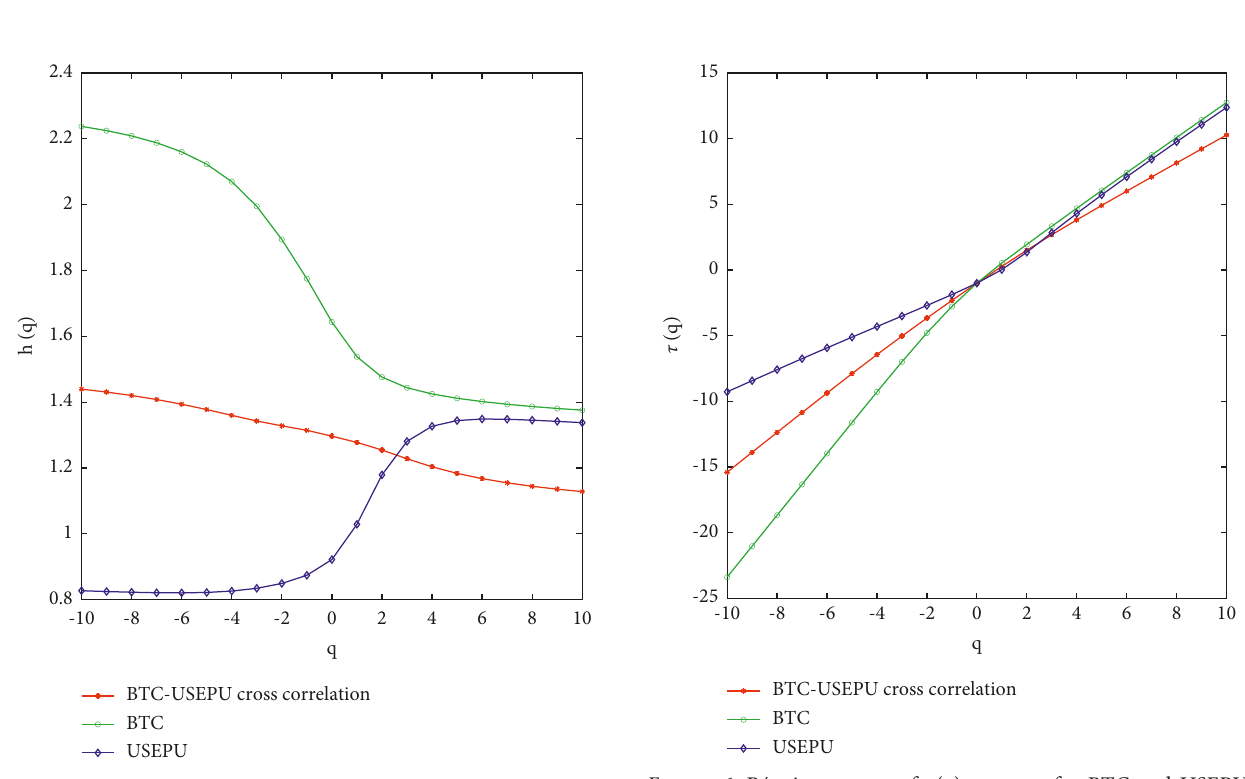
( s ) versus s for BTC and USEPU. q